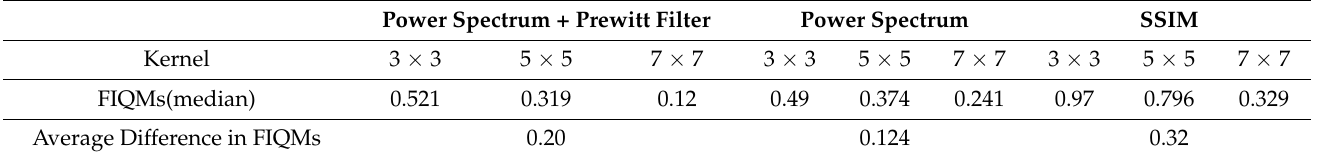
Figure 8. Experimental results of Good/Faulty Assessment: ( a ) box and whisker plot and ( b ) line chart. Table 1. FIQMs with different levels of blurring for the proposed and conventional algorithm.